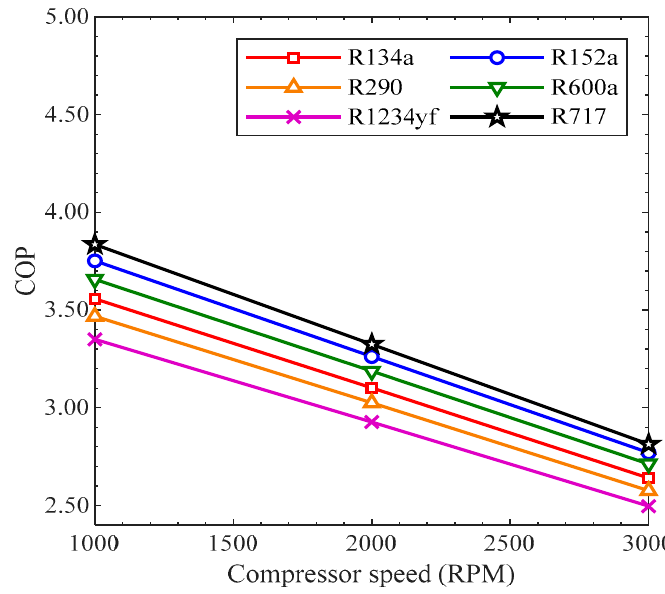
Figure 9. COP vs. compressor speed trends for various refrigerants .